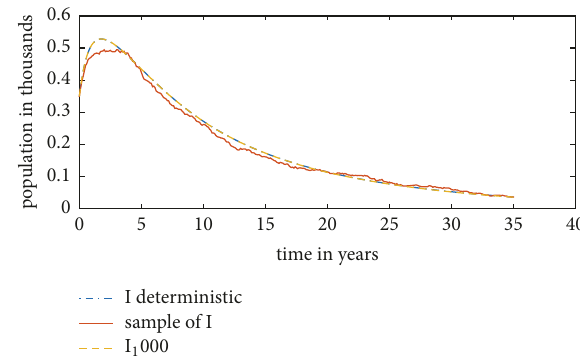
Figure 1: 𝑅 0 = 1.3917 , 𝑅 𝜎 = 1.1653 , 𝑐 1 = 0.000065 , and 𝜎 = 0.04